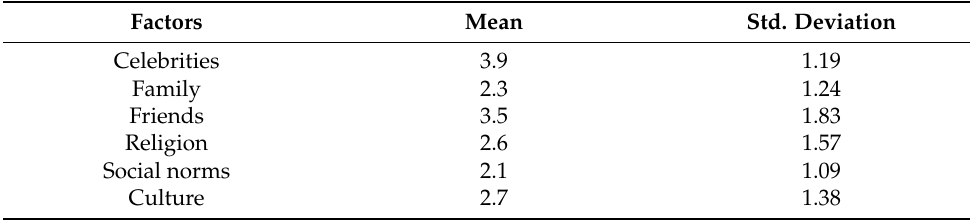
Table A3. External factors influence on purchasing luxury